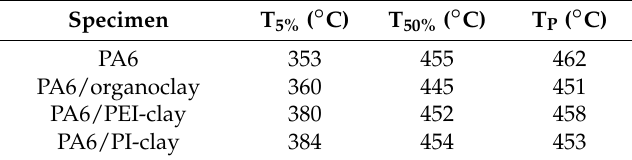
Figure 4. Thermogravimetric curves under oxidative conditions for neat PA6 and its clay composites. Table 2. T 5% , T 50% , and T P from thermogravimetric analysis thermograms for PA6 and its composites. Specimen T 5% ( ◦ C) T 50% ( ◦ C) T P ( ◦